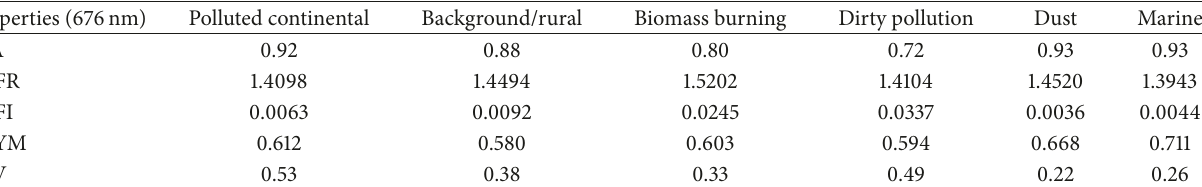
Table 3: Characteristics of global aerosol types by Omar et al. (2005).